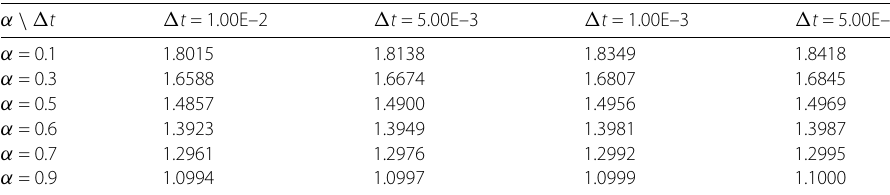
Table 4 Temporal convergence orders of v for Example 4.2